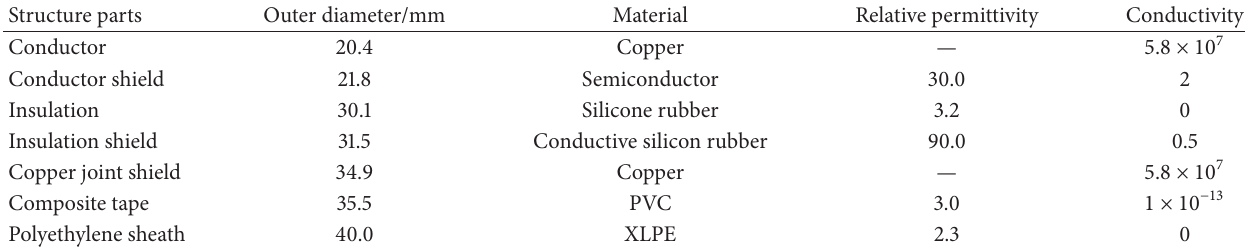
Table 1: Materials electrical characteristics of the model.